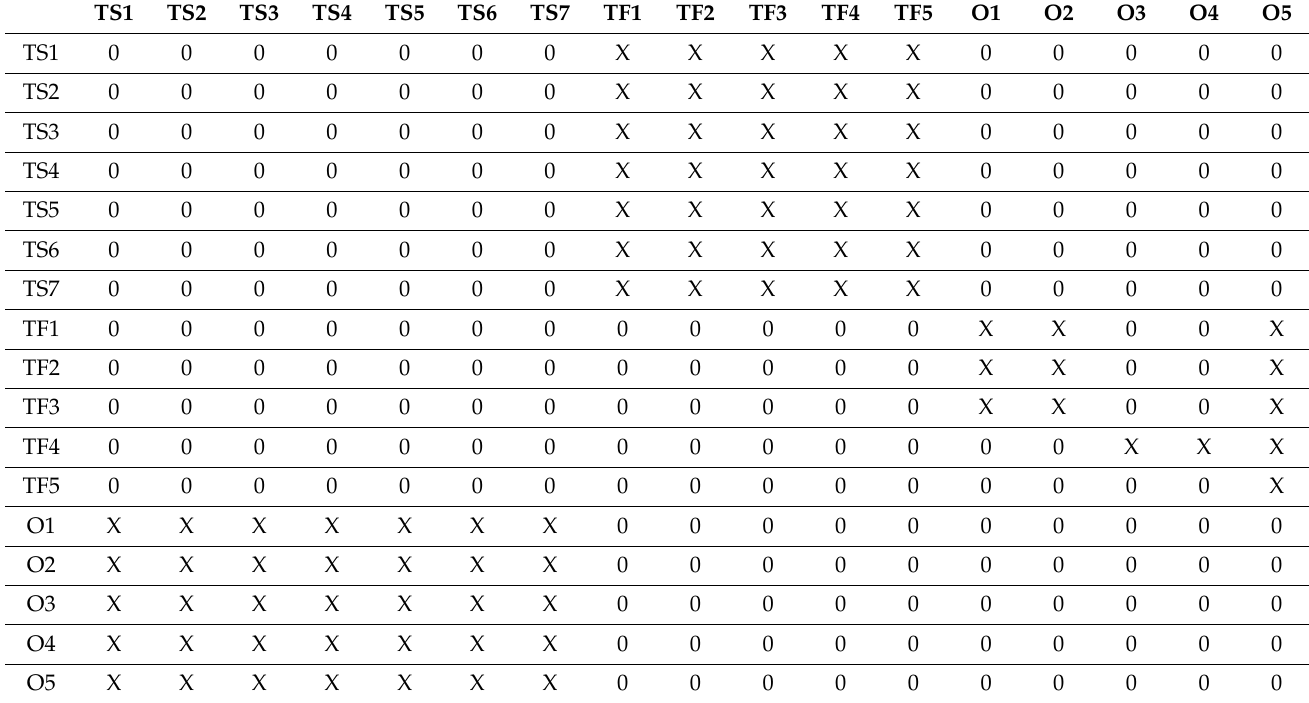
Table 3. Possible transitions between the states in the first-order Markov